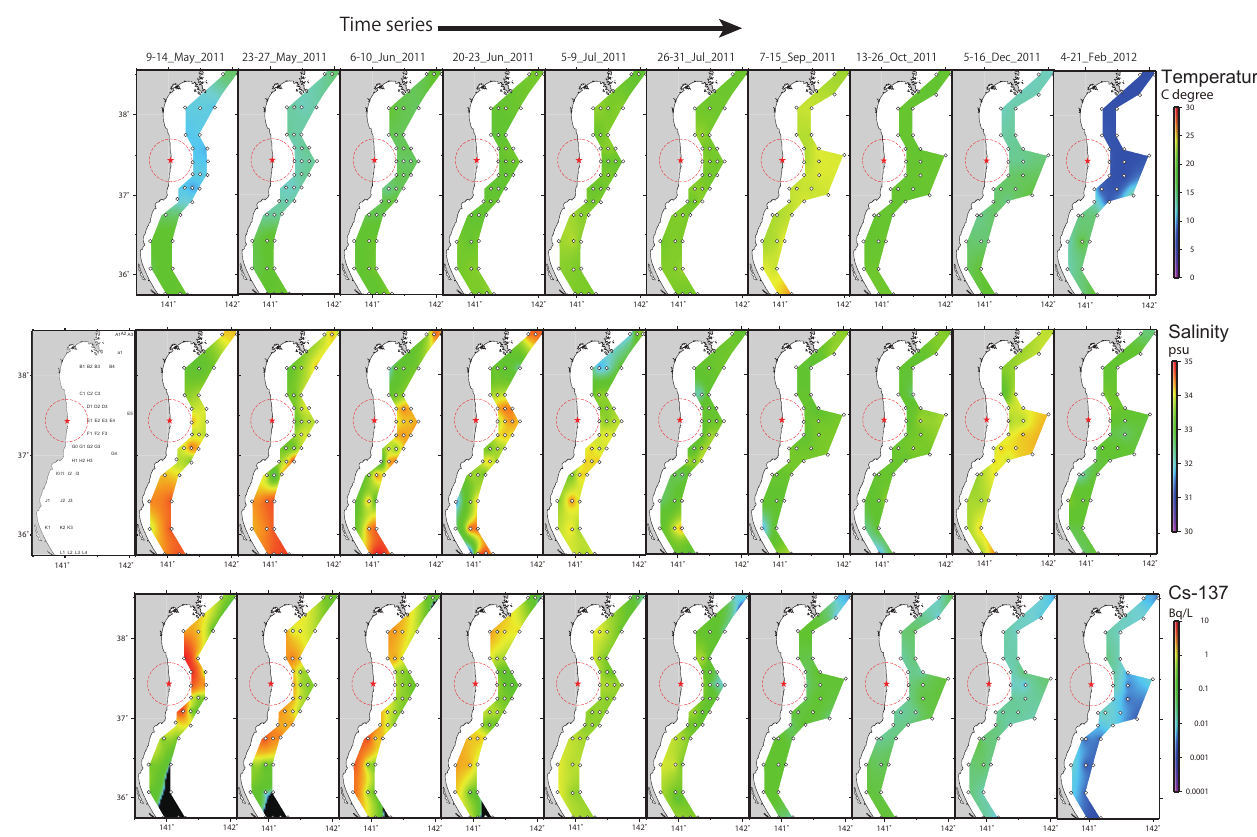
Fig. 4. Horizontal distributions of temperature (A) , salinity (B) , and 137 Cs activities (C) in surface water and their temporal changes from 9–14 May 2011 to 4–21 February